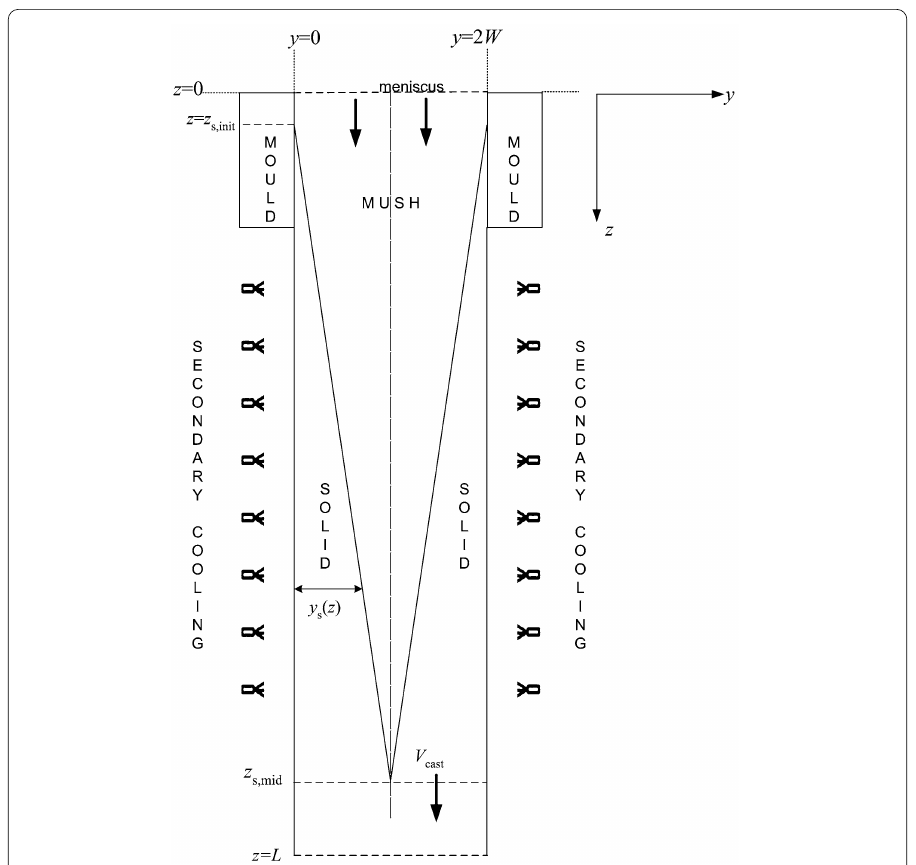
Figure 3 2D schematic for the idealized continuous casting of